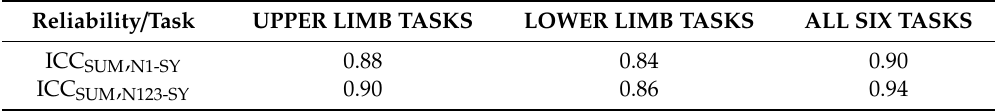
Table 2. Intra class correlation coe ffi cients a for system and raters’ agreement (on group of